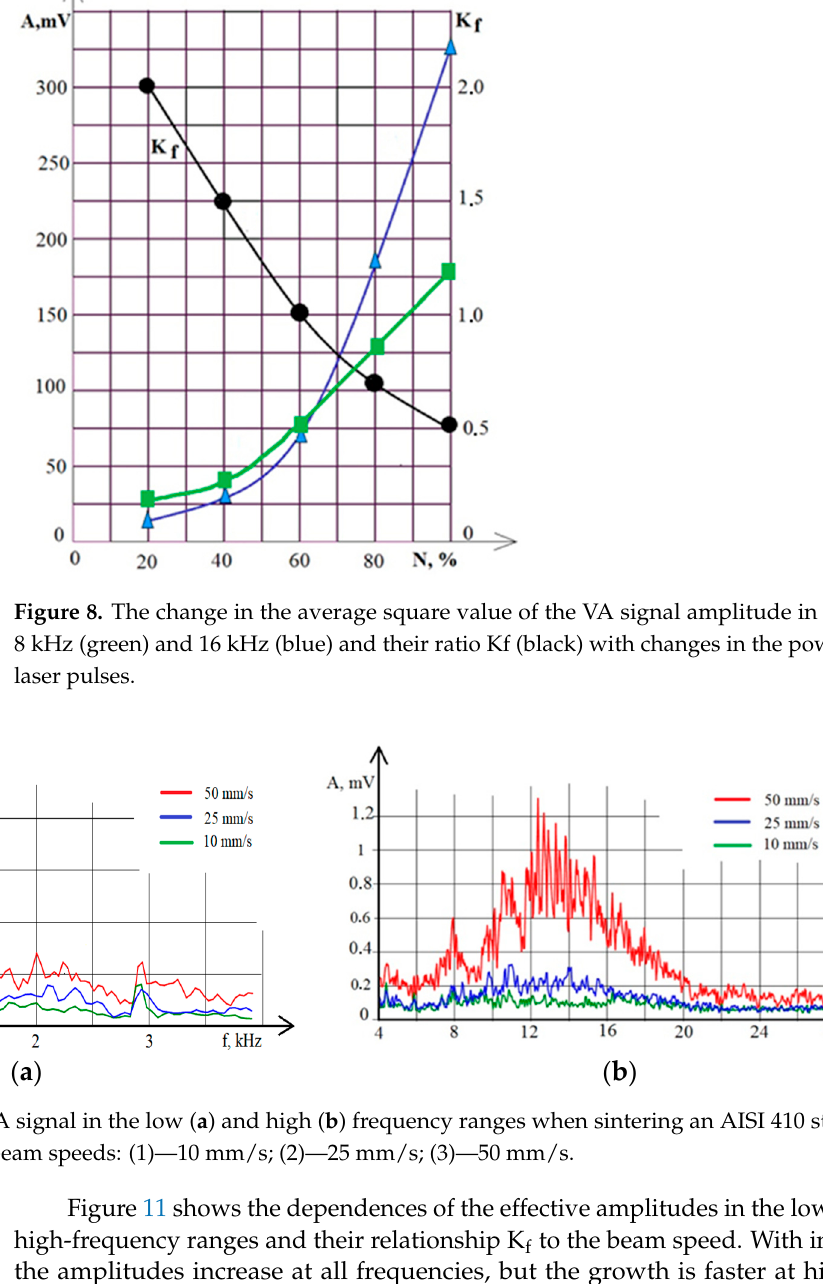
Figure 9. Spectra of the VA signal in the low ( a ) and high ( b ) frequency ranges when sintering an AISI 410 steel powder layer with different laser beam speeds: (1)—10 mm/s; (2)—25 mm/s; (3)—50 mm/s.